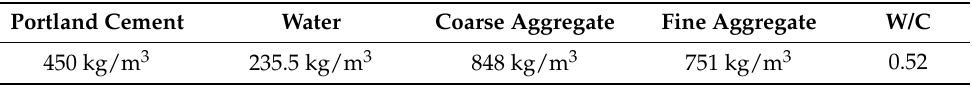
Table 1. Mix design for 1 m 3 of